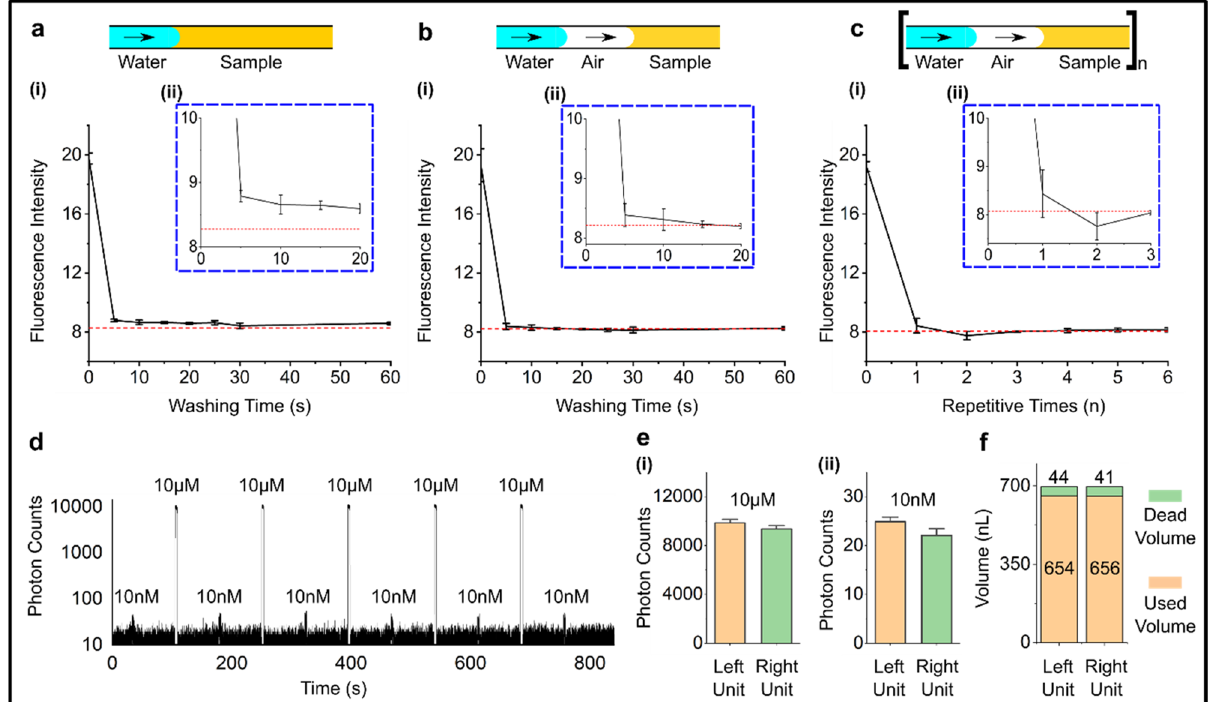
Figure 4. Characterization of cleaning efficiency and dead volume. Three cleaning protocols—( a ) direct continuous DI water wash, ( b ) air evacuation before continuous DI water wash, and ( c ) cyclic air evacuation and DI water wash—are evaluated after a fluorescence dye (FAM) is loaded into a TESLI sample storage channel. ( i ) Fluorescence signals in the sample storage channel between FAM (i.e., channel intensity at time 0) and water (i.e., baseline intensity; red dash line) as a function of washing time/repetition for the three cleaning protocols show that the second and the third protocols provide more effective cleaning, which is evident through the ( ii ) inset plots. ( d ) Effective cleaning via air evacuation before continuous water wash is additionally demonstrated by alternate loading of 10 nM FAM and 10 µM FAM through a single TESLI with this cleaning protocol in between. Droplet generation from each FAM dye and subsequent fluorescence detection of each droplet by the custom LIF detector yield a fluorescence trace that reveals alternating weak and strong fluorescence signals corresponding to 10 nM and 10 µM FAM, which can only be observed if 10 µM FAM is effectively washed. ( e ) Both the left TESLI and the right TESLI achieve comparable cleaning efficiencies. ( f ) The dead volumes— measured by the difference between a fixed sample volume (700 nL here) and the used volume (i.e., total volume of the droplets generated from the sample)—of the left and the right TESLIs are 44 nL and 41 nL, respectively. In ( a ), ( b ), ( c ), and ( e ), the error bars depict ± 1 standard